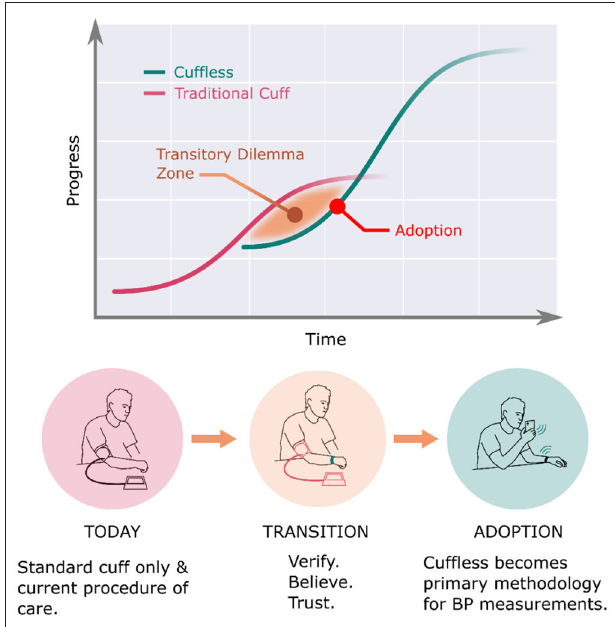
FIGURE 10 | Natural transition period from standard cuff BPM to cuffless